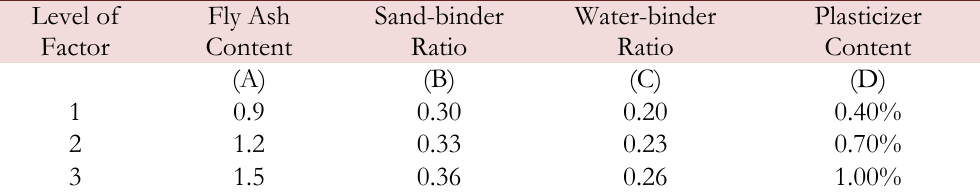
Table 1: Factors and levels of orthogonal